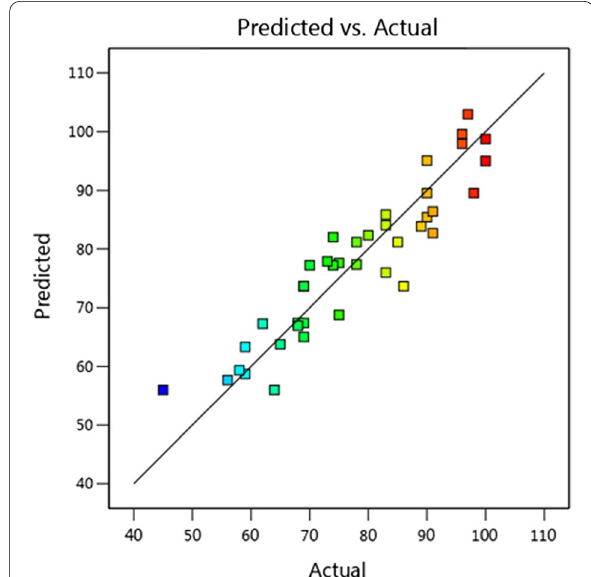
Fig. 6 Actual and predicted values of biosurfactant production in RSM software by Kocuria rosea ABR6